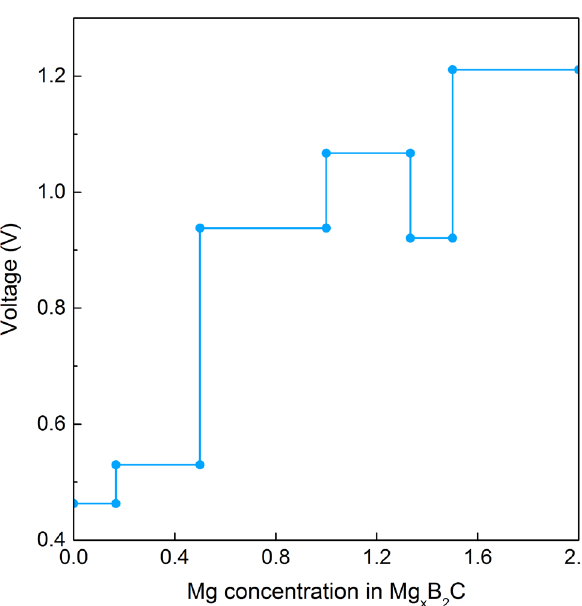
Figure 4. Calculated voltage profile with respect to Mg content from 0 to